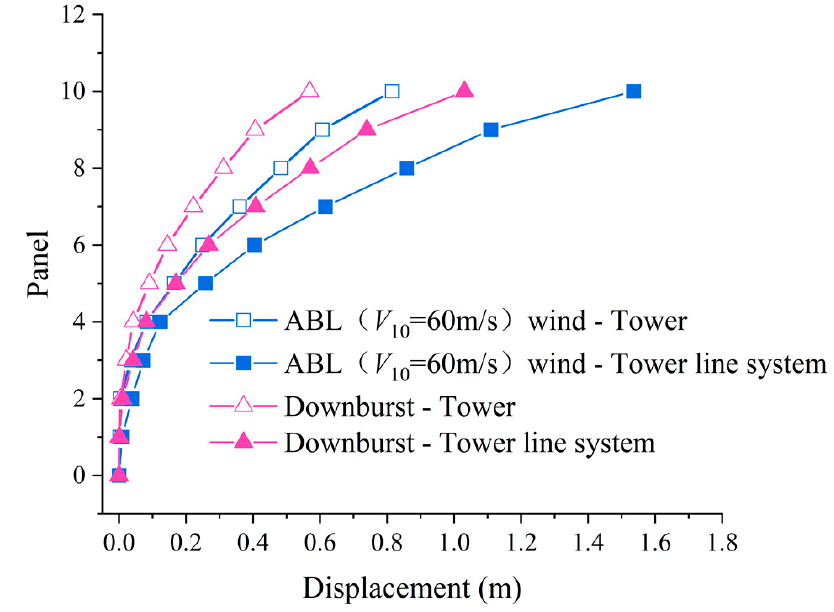
Figure 8. Displacement comparison of transmission tower ( V 10 = 60 m/s).